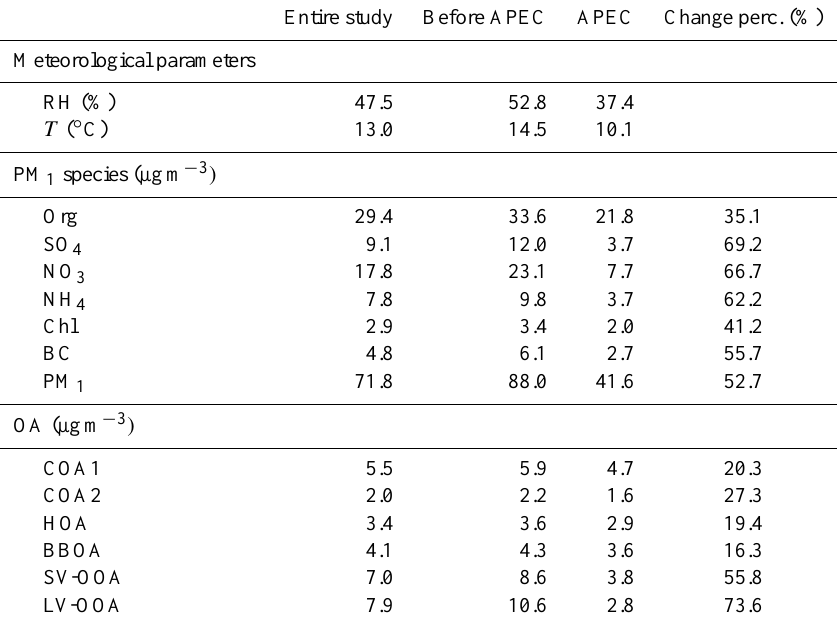
Table 1. Summary of average meteorological parameters, mass concentrations of PM 1 species and OA factors for the entire study, before and during APEC, and also the change percentages during